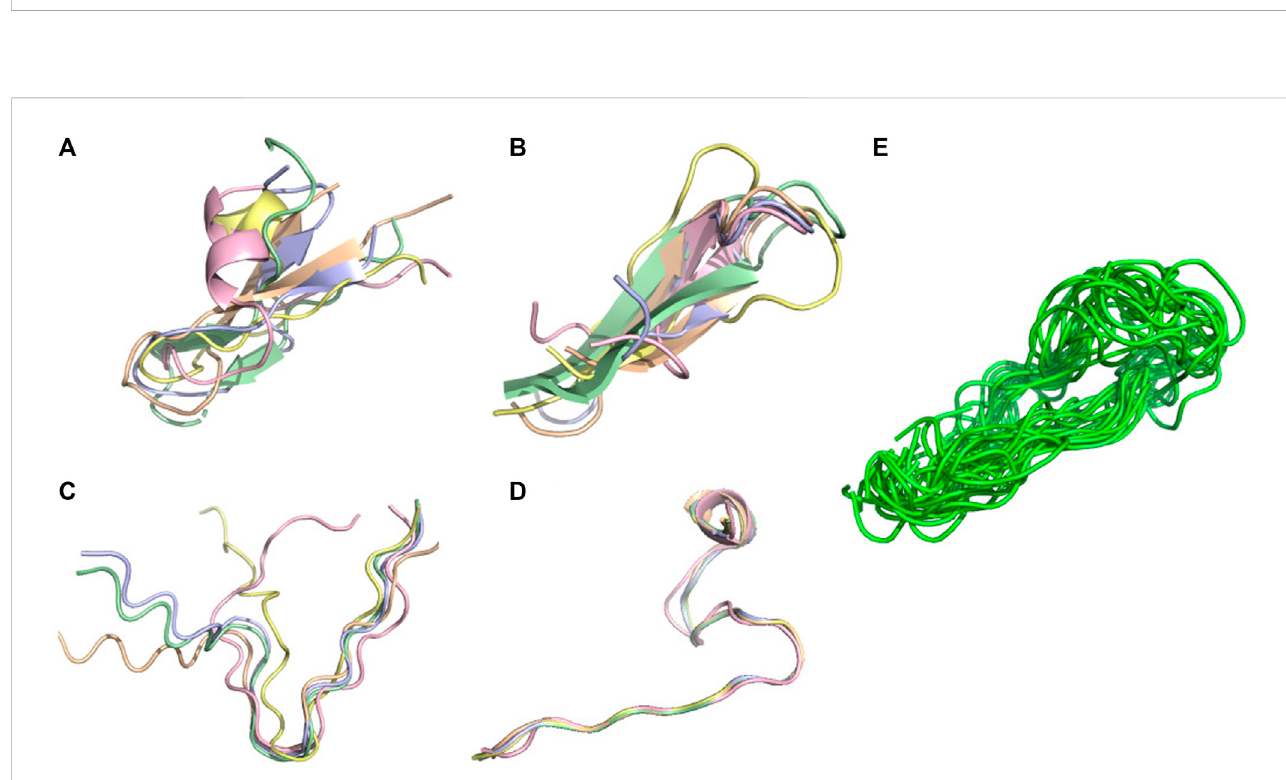
FIGURE 5 Conformational ensemble of 1egs. (A) PF-noDH, (B) PF-DH at pH 4.3, (C) AlphaFold2, (D) NMR structure. For A, B and C, the 5 predicted models are depicted. For D, all models provided in the PDB are depicted.